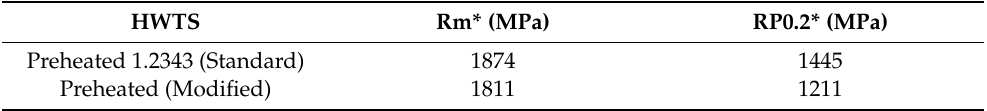
Table 3. The results of the tensile test (standard 1.2343 and modified 1.2343).